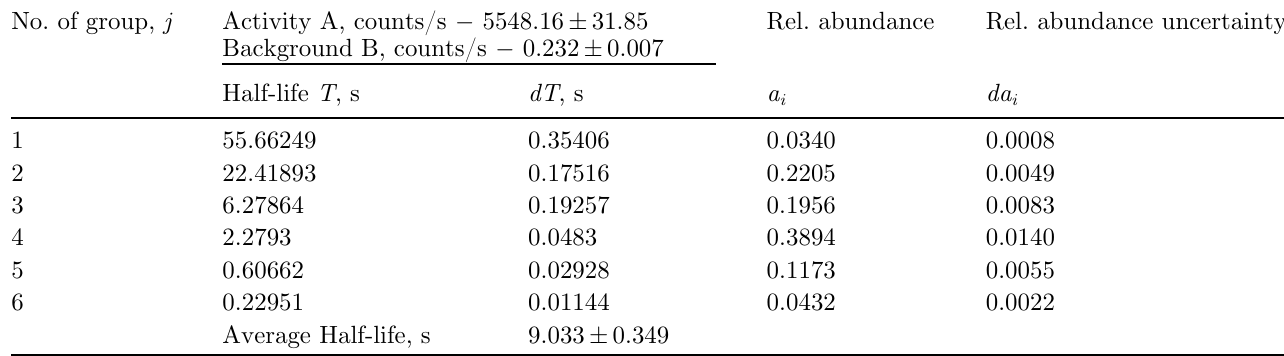
Table 8. The 6-group DN parameters ( a fi ssion of 235 U by thermal neutrons.